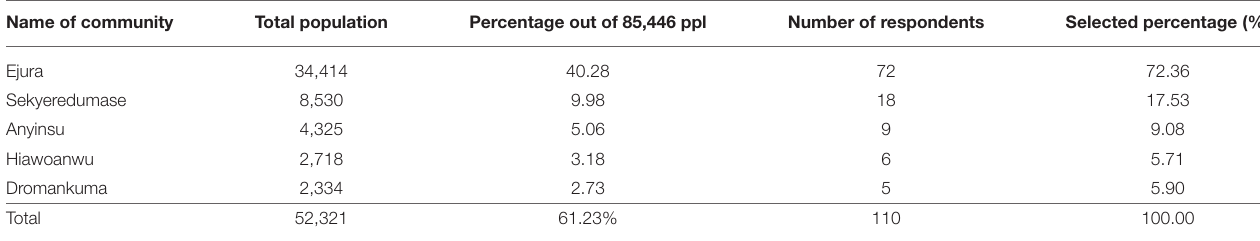
TABLE 3 | Respondent selection and distribution